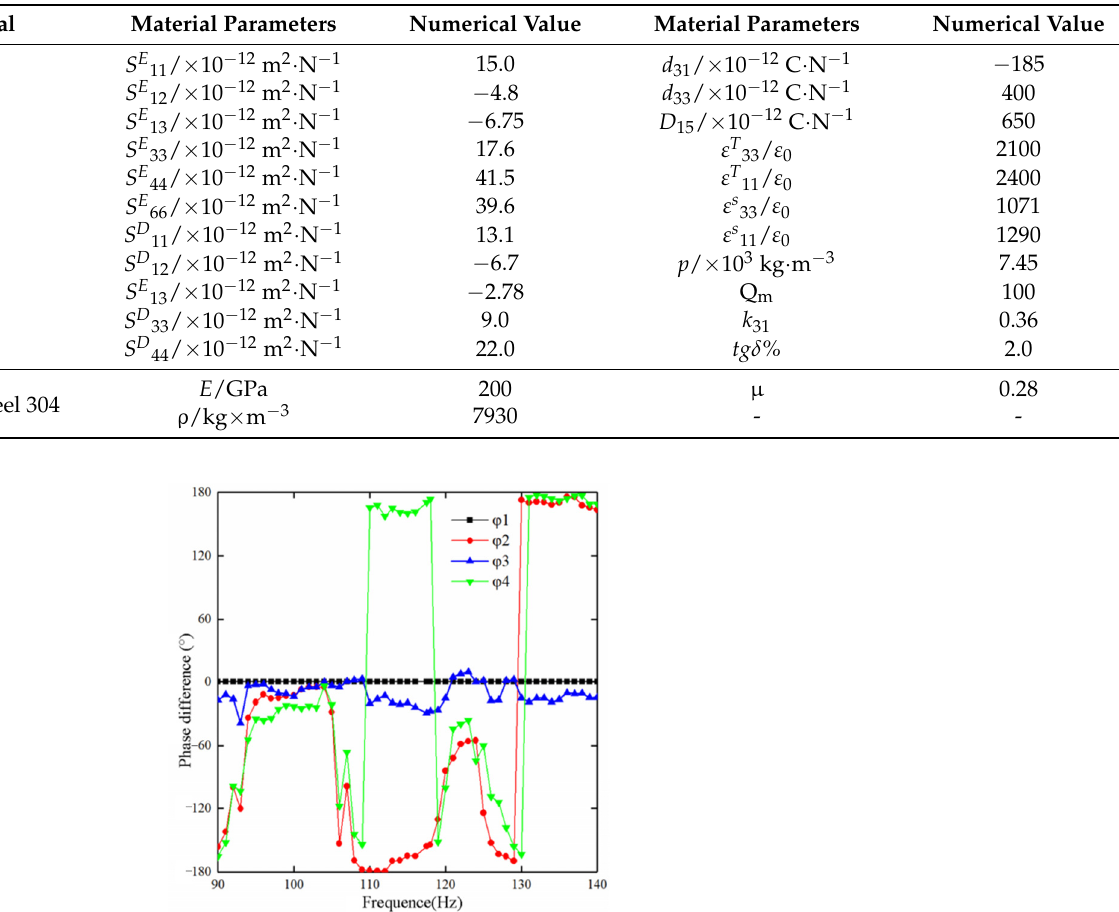
Table 3. Structural parameters of piezoelectric materials.